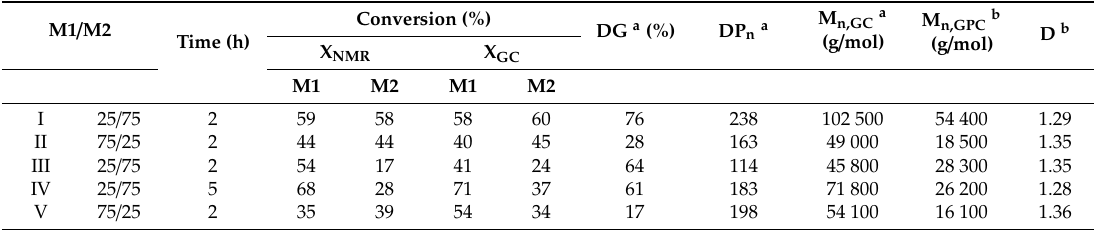
Table 1. Data for AlHEMA / MPEGMA copolymers synthesized by